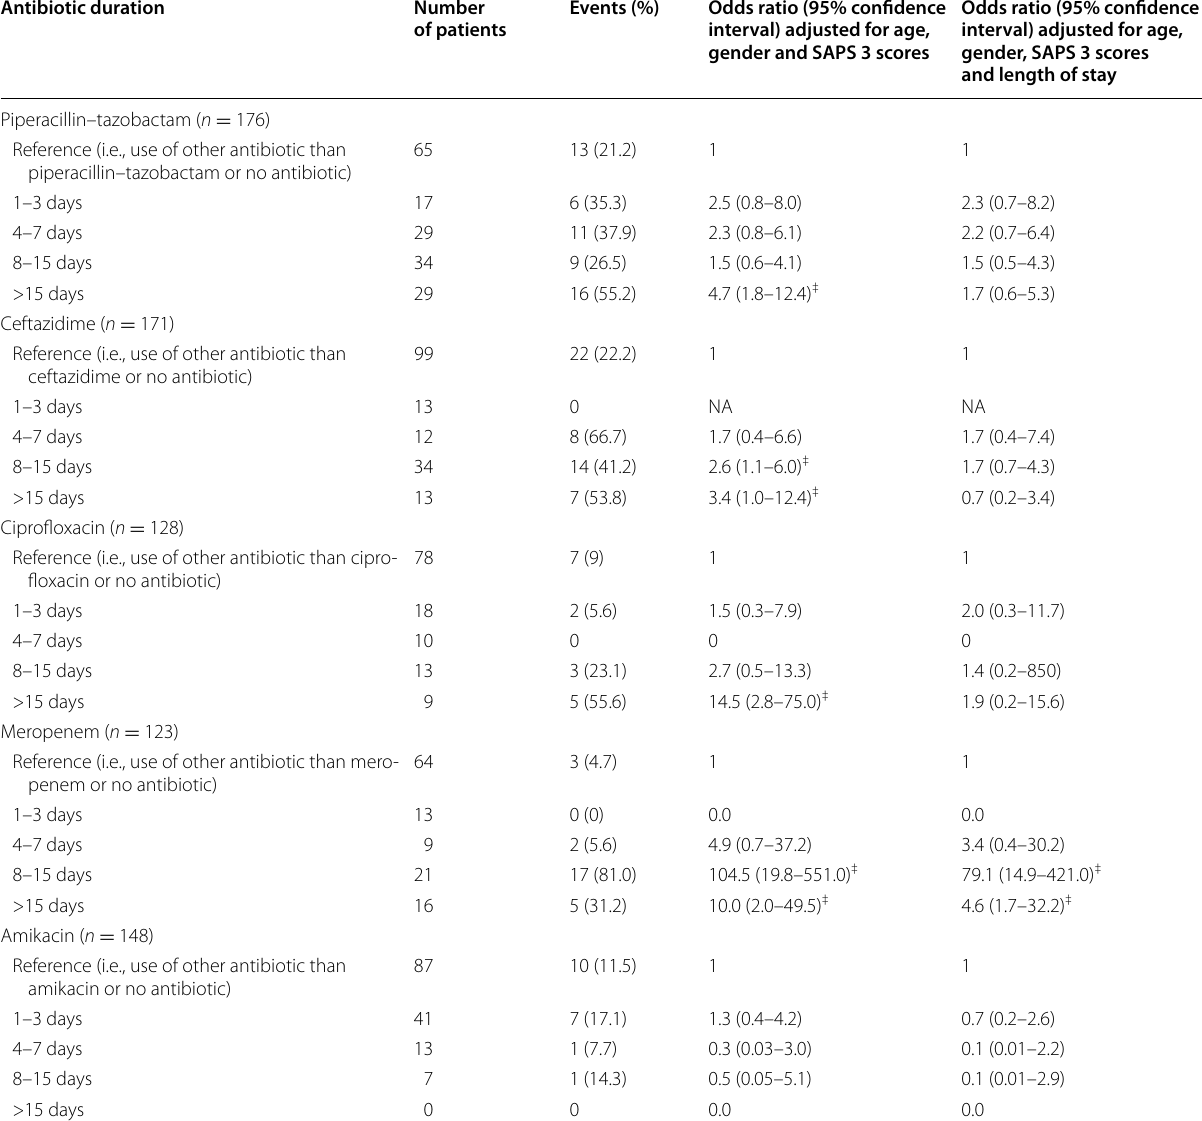
Table 2 Odds ratios for the emergence of antipseudomonal antibiotic resistance by Pseudomonas aeruginosa in relation to antibiotic